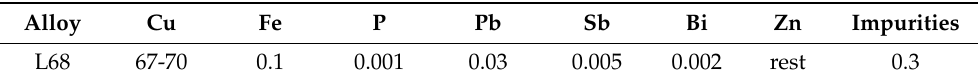
Table 1. The chemical composition of brass in mas.% L68 (according to GOST 15527-2004), analogue American C26800, German